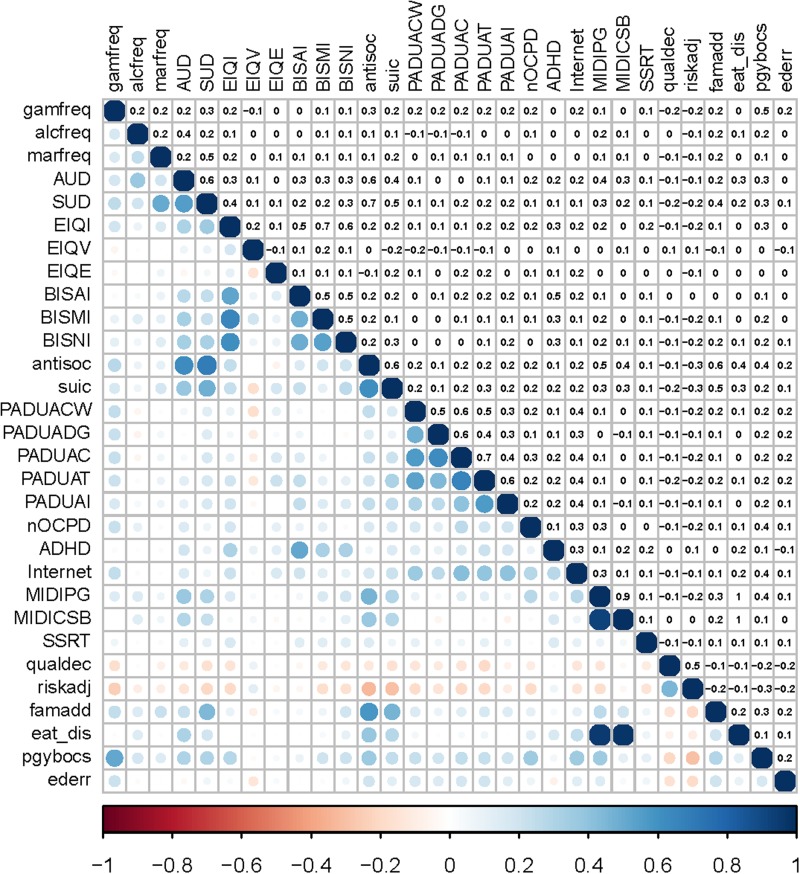
Heat map showing correlations between variables of interest. Left: positive
correlations are shown in blue, and negative in red; larger dots are indicative of
stronger correlations. Right: correlation coefficients (rounded to one decimal place
in the interests of clarity). gamfreq, gambling frequency per week; alcfreq, alcohol
frequency per week; marfreq, marihuana frequency per week; AUD, alcohol use disorder;
SUD, substance use disorder; EIQI, Eysenck Inventory Impulsiveness; EIQV, Eysenck
Inventory Venturesomeness; EIQE, Eysenck Inventory Extraversion; BISAI, Barratt
Attentional Impulsiveness; BISMI, Barratt Motor Impulsiveness; BISNI, Barratt
Non-Planning Impulsiveness; antisoc, antisocial personality disorder; suic,
suicidality on the Mini International Neuropsychiatric Inventory; PADUACW, Padua
Inventory Contamination and Washing subscale; PADUADG, Padua Inventory
Dressing/Grooming subscale; PADUAC, Padua Inventory Checking subscale; PADUAT, Padua
Inventory Thoughts of Harm to Self-others subscale; PADUAI, Padua Inventory Impulses
to Harm Self/Others subscale; nOCPD, number of obsessive-compulsive personality
disorder criteria met; ADHD, total score on attention-deficit hyperactivity disorder
screen; Internet, total score on Young's Internet Addiction Test; MIDIPG, gambling
disorder; SSRT, stop-signal reaction time on Stop-Signal Test; qualdec, quality of
decision-making on the Cambridge Gamble Test; riskadj, risk adjustment on the Cambrige
Gamble Test; eat_dis, eating disorder; pgybocs, Pathological Gambling Yale Brown
Obsessive–Compulsive Disorder Scale; ederr, extra-dimensional errors on the
set-shifting task.